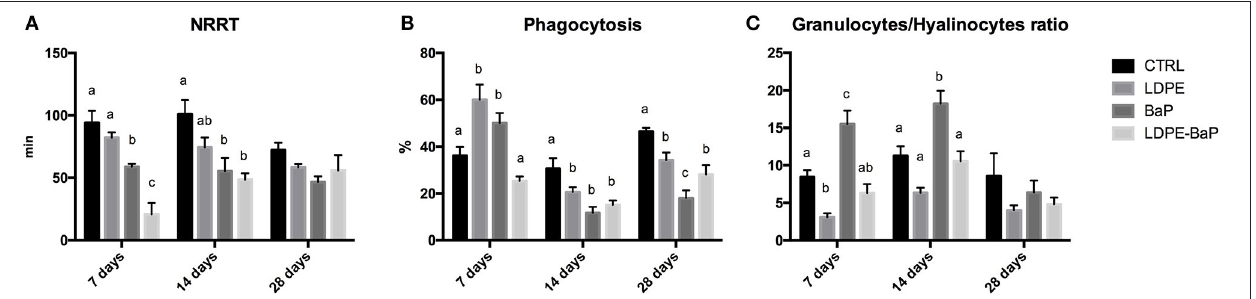
FIGURE 3 | Immunological biomarkers in mussels exposed for 7, 14, and 28 days to various treatments (CTRL, control; LDPE, virgin low density polyethylene; BaP, benzo(a)pyrene alone; LDPE-BaP, benzo(a)pyrene-contaminated polyethylene). NRRT: neutral red retention time (A) , Phagocytosis (B) , Granulocytes/Hyalinocytes ratio (C) . Data are expressed as mean values ± standard error, n = 4; different letters indicate significant differences between groups of means within the same time of exposure ( post-hoc Newman-Keuls